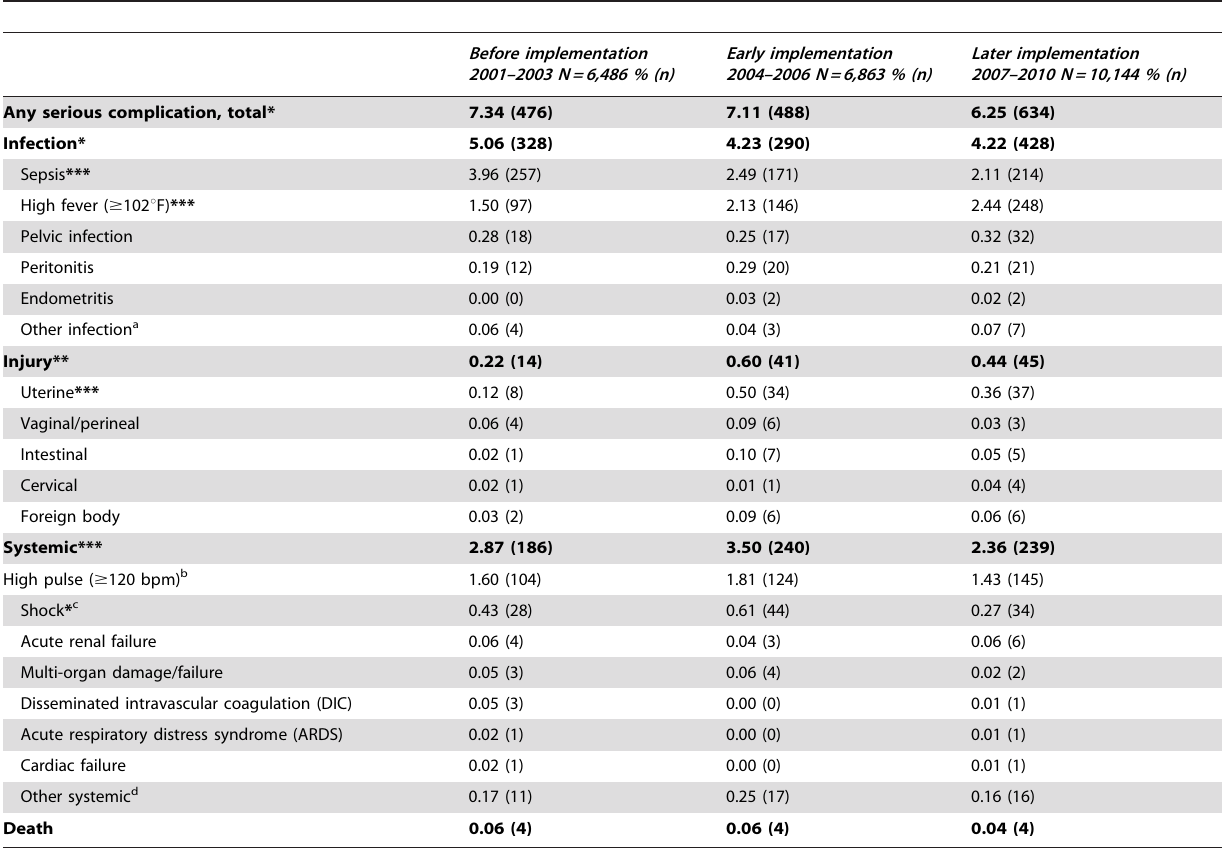
Table 2. Serious abortion complications as a proportion of all abortion complications presenting at hospitals before and after implementation of legal abortion in Nepal,